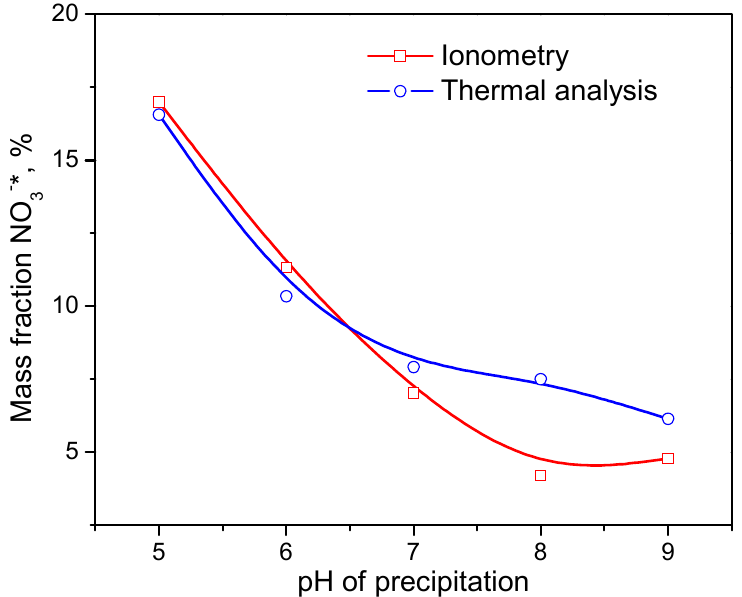
Figure 5. The content of aluminum-bound nitrate ions NO 3 − * (not included in NH 4 NO 3 ) according to ionometry and thermal analysis.